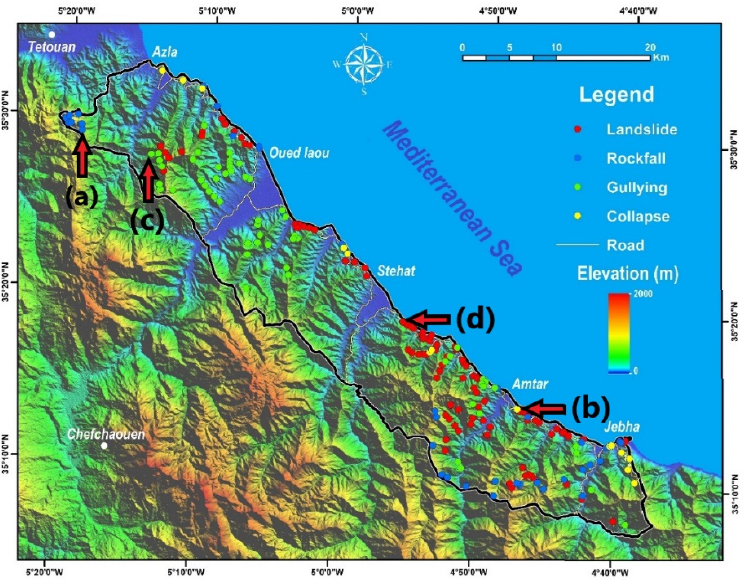
Figure 3. Ground instability inventory map of the area [19]. (a, b, c, d correspond to Figure 4).